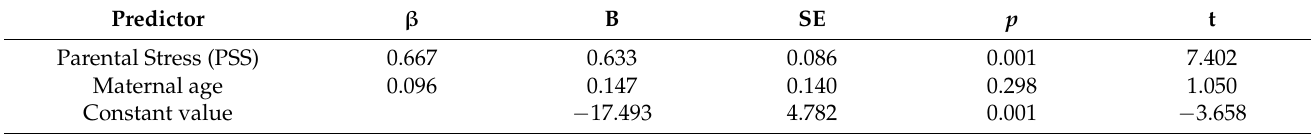
Table 6. Results of the regression analyses for maternal postpartum bonding.